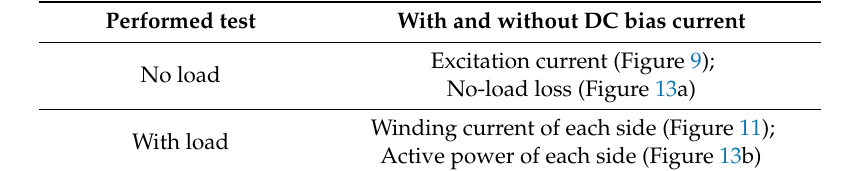
Figure 10. Magnitudes of harmonics of each winding current under various DC bias current. ( a ) series winding current. ( b ) common winding current. ( c ) low voltage winding current. ( d ) excitation current. Table 4. Performed test with RSM. Table 4. Performed test with RSM.